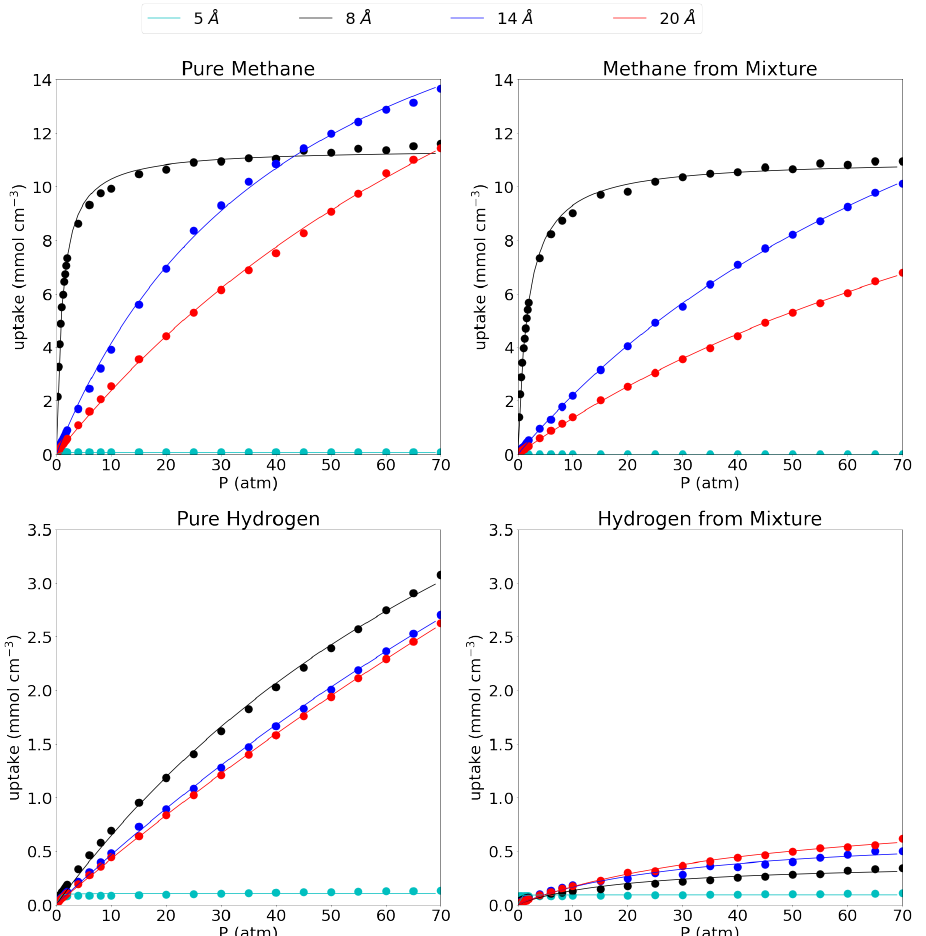
Figure 2. Absolute adsorption isotherms for pure methane ( top left ), methane from the equimolar mixture ( top right ), pure hydrogen ( bottom left ) and hydrogen from the equimolar mixture ( bottom right ) at 300 K. The dots represent calculated values, while the full lines show the fitted Langmuir isotherm. Please notice the different scales on the y-axes. Table 2. The absolute uptakes in the bulk in mmol cm − 3 for the pure methane, pure hydrogen and both in their equimolar mixture at pressures of 1 atm and 70 atm (between brackets), both at 300 K. Pore Size (Å) Pure CH